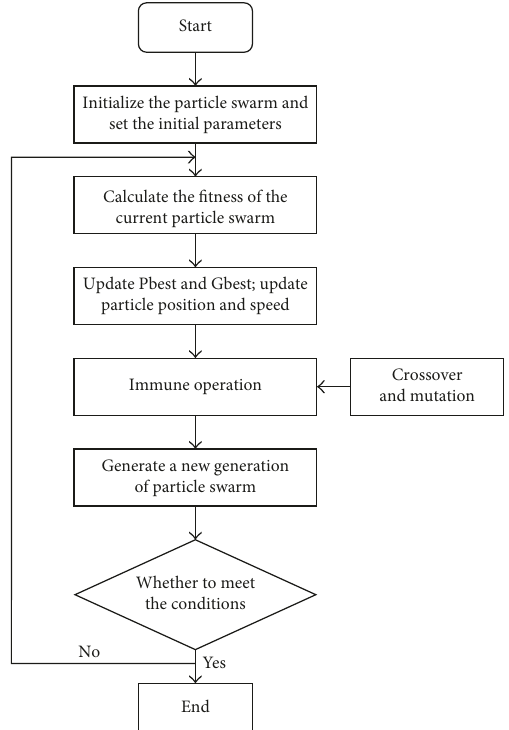
Figure 4: Parameter optimization process.